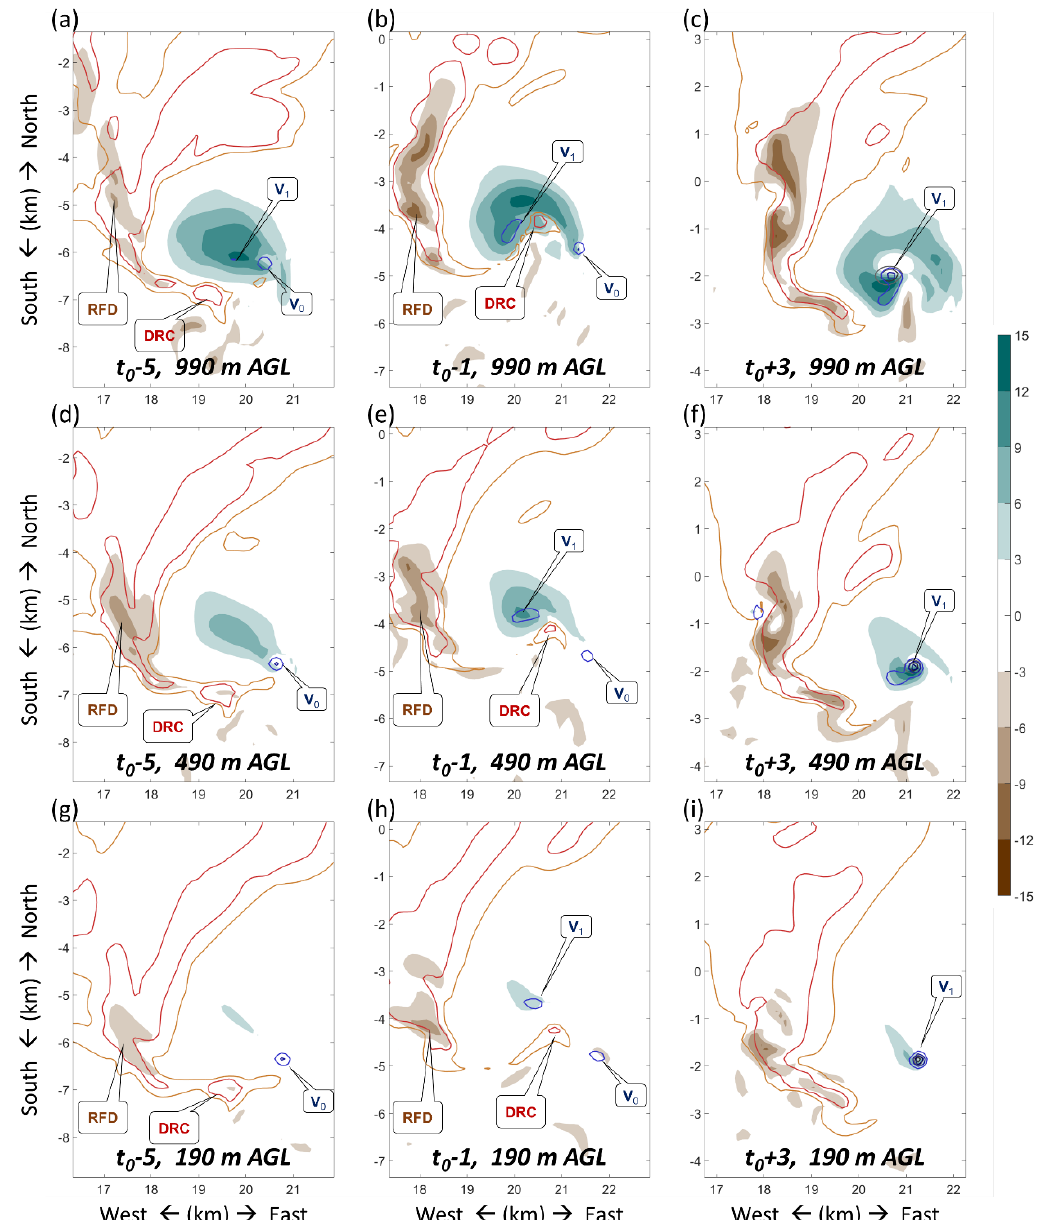
Figure 6. Horizontal cross-section of the simulated supercell and tornado during DRC formation and tornadogenesis at the height of ( a − c ) 990 m, ( d − f ) 490 m and ( g − i ) 190 m AGL at (left column) t 0 − 5 min, (middle column) t 0 − 1 min and (right column) t 0 + 3 min. Vertical velocity is given by shaded contours. Reflectivity of 40 (50) dBZ is given by orange (red) contours. Vertical vorticity of 0.05, 0.1 and 0.15 s − 1 is given by blue contours. Pressure perturbation of -1.5 and -2 hPa is given by dark grey contours. V 0 denotes the vanishing vortex associated with the DRC, while V 1 denotes the downward developing tornadic vortex.